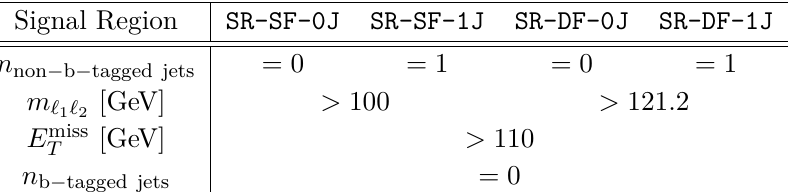
Table 1 . Definitions of the signal regions (SRs) in the 2 ‘ + E miss E miss